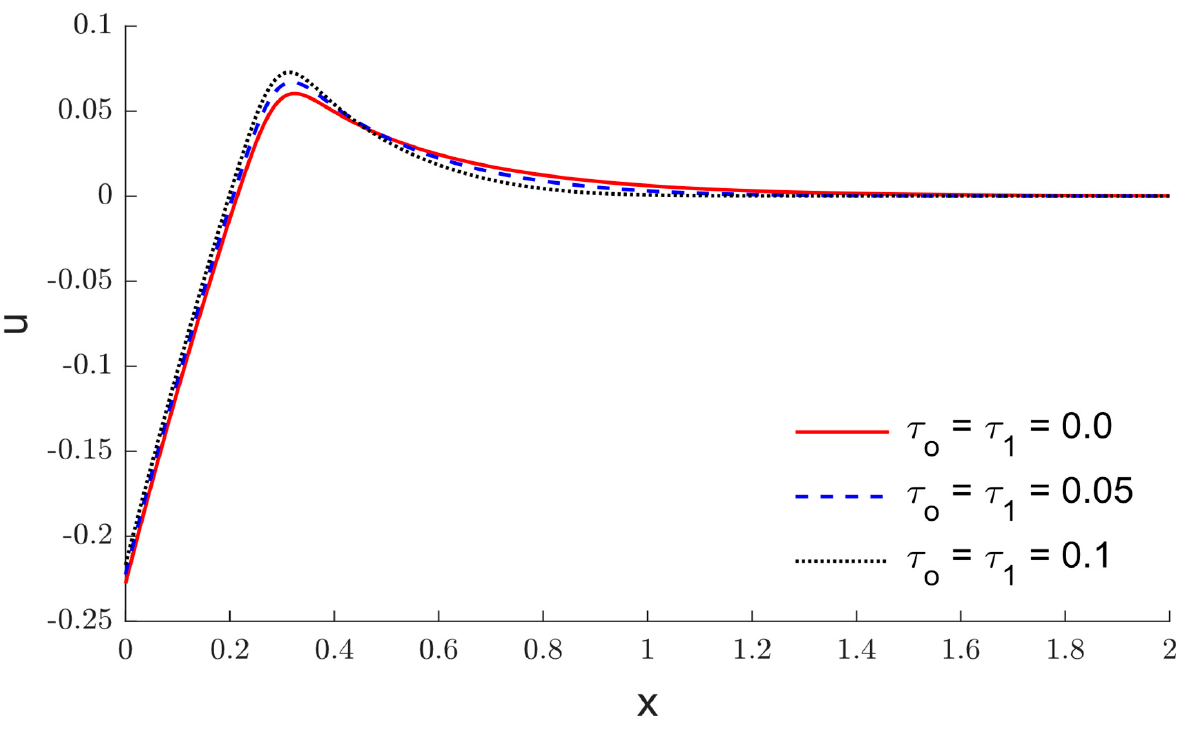
Figure 7. The impact of thermal relaxation times τ o , τ 1 in the displacement variation u via the distance x when K n = 0.5 .